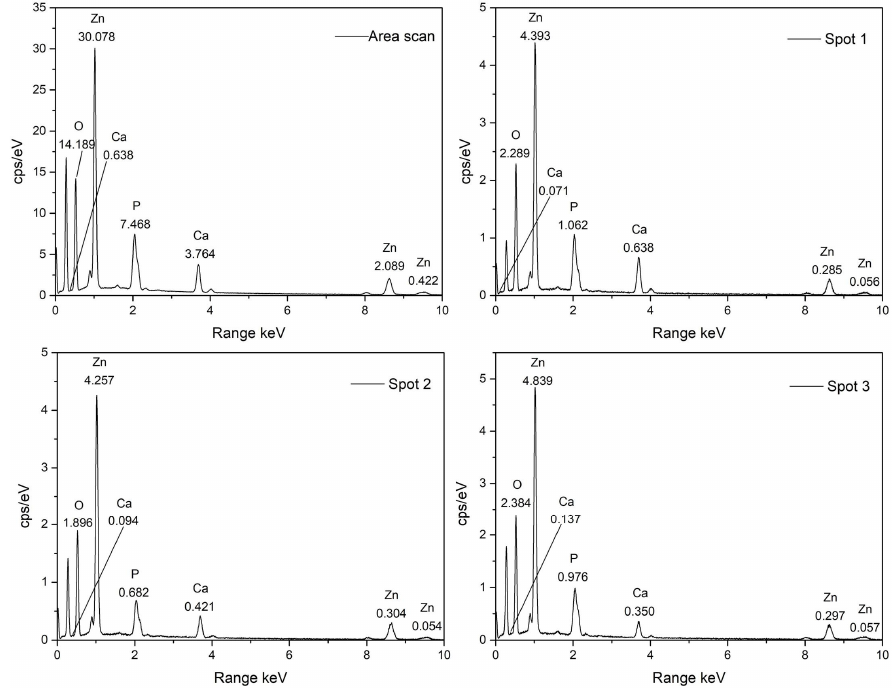
Figure 6. EDS analysis of area scan and three selected spots in Figure 5. Table 1. EDS analysis results of the area scan and three selected spots shown in Figure 6. Area (wt.%)